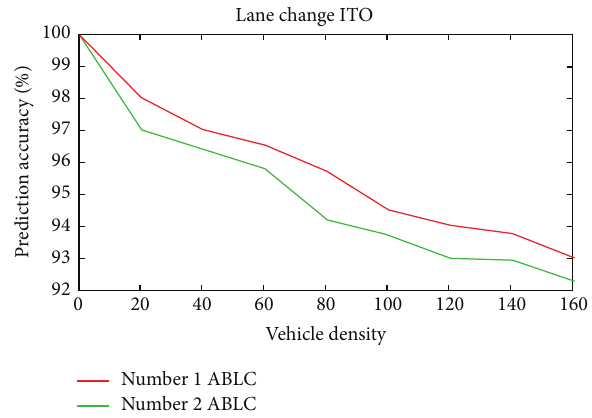
Figure 13: Prediction accuracy versus vehicle density for Scenario 3( a ) .